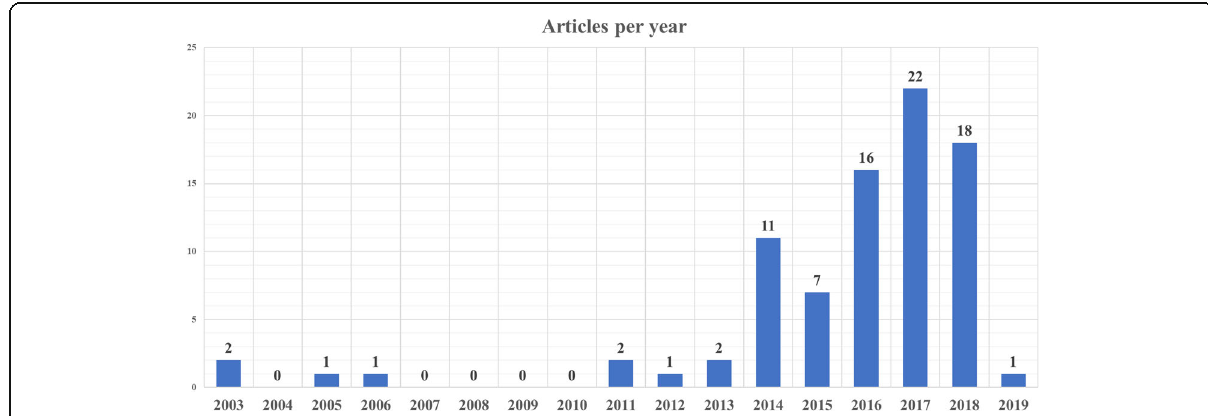
Fig. 7 Graphic showing the number of articles published per year regarding contrast-enhanced spectral